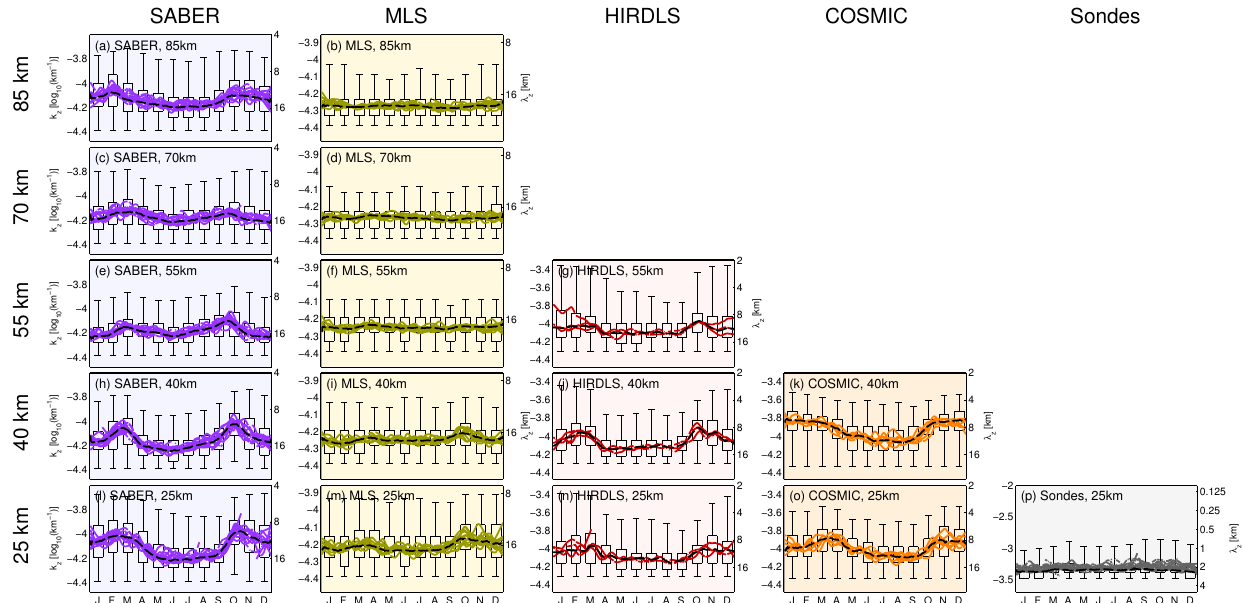
Figure 17. As Fig. 12, showing interannual variability of the each observed λ z distribution.